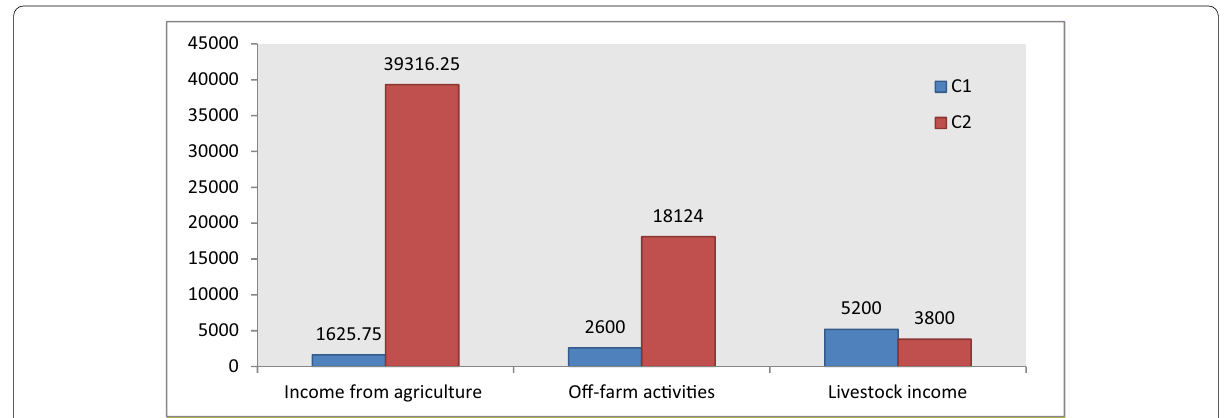
Fig. 3 The relative dimensions of Non-forest livelihood income by source and category (collected by households/year, ETB)